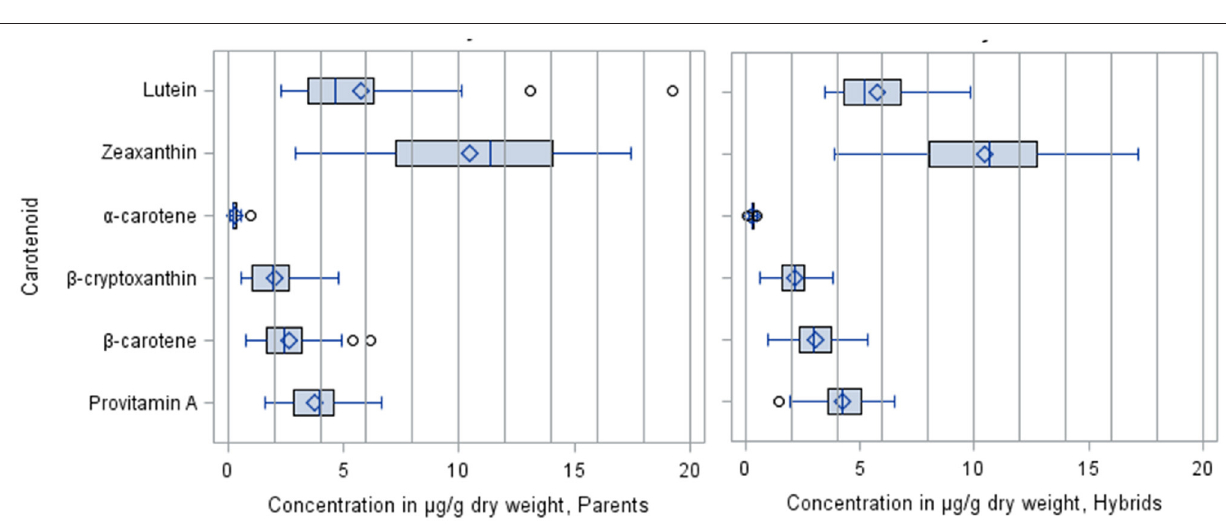
FIGURE 2 | Distribution of carotenoid levels ( µ g/g) in the parental inbred lines and the F1